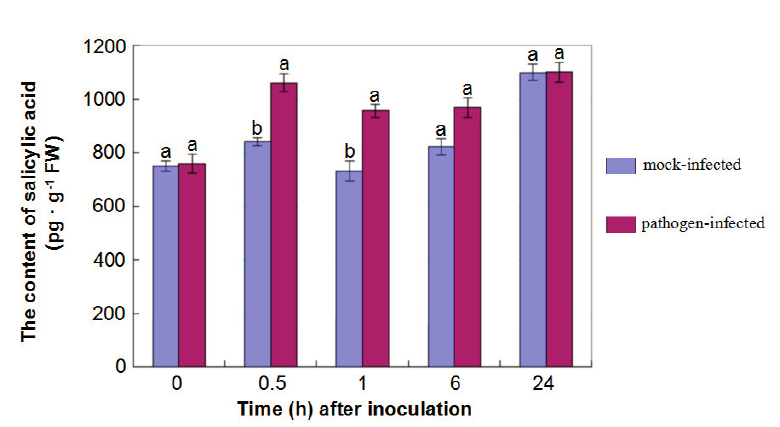
Figure 6. Content of salicylic acid in hypocotyls after inoculation. Data represented the content of salicylic acid in the hypocotyls of G. thurberi seedlings in response to V. dahliae infection at 0, 0.5, 1, 6, 24 h after mock- and fungal-inoculation. Means significantly different from one another (at 0.5, 1, 6 h after inoculation) by Tukey ( α = 0.05) were shown as different letters on each column.